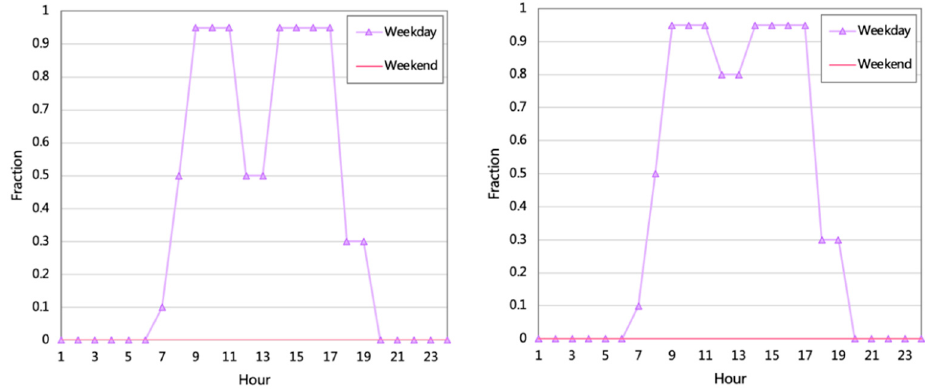
Figure 3. Schedule of lighting and people ( right ), schedule of equipment ( left ). Table 3. Input parameters for SA.